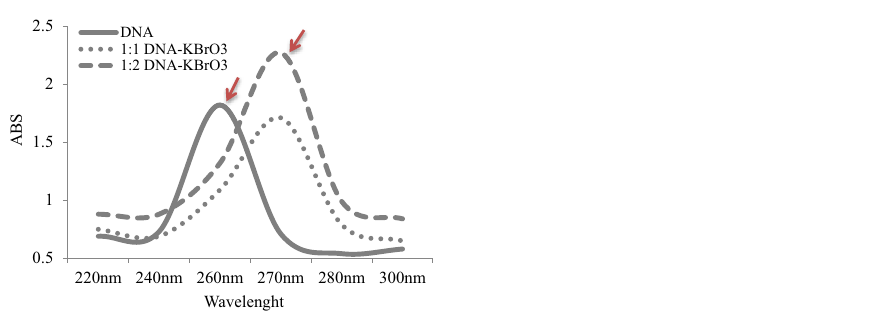
Figure 5. Absorption spectra of DNA in the presence of KBrO 3 at different concentrations. Arrow shows the absorbance and wavelength changes.